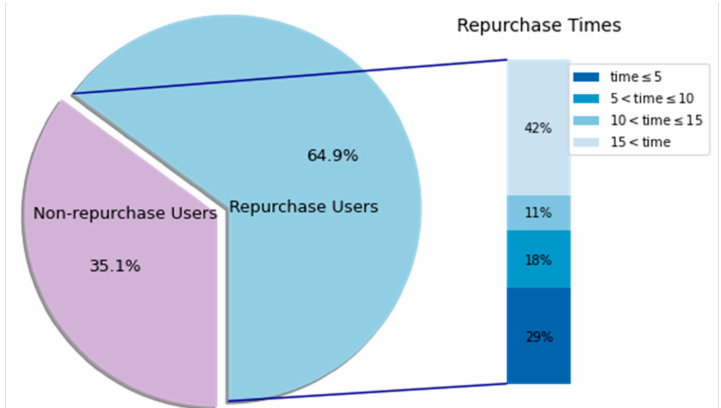
Figure 3. Proportions of repurchase